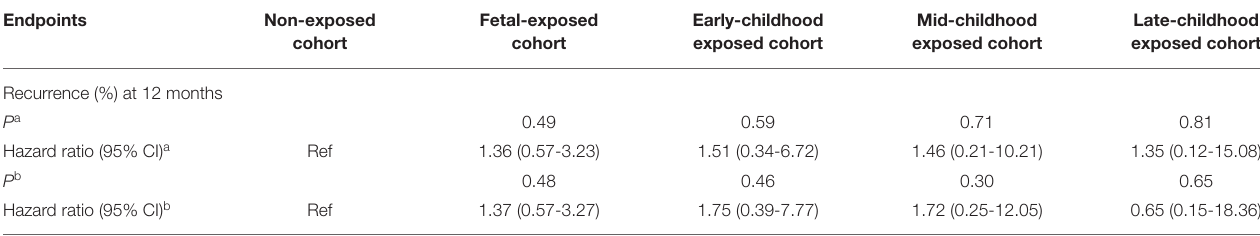
TABLE 3 | Twelve-month recurrence among patients receiving medical care adherence to performance measurements vs. routine care. Endpoints Non-exposed